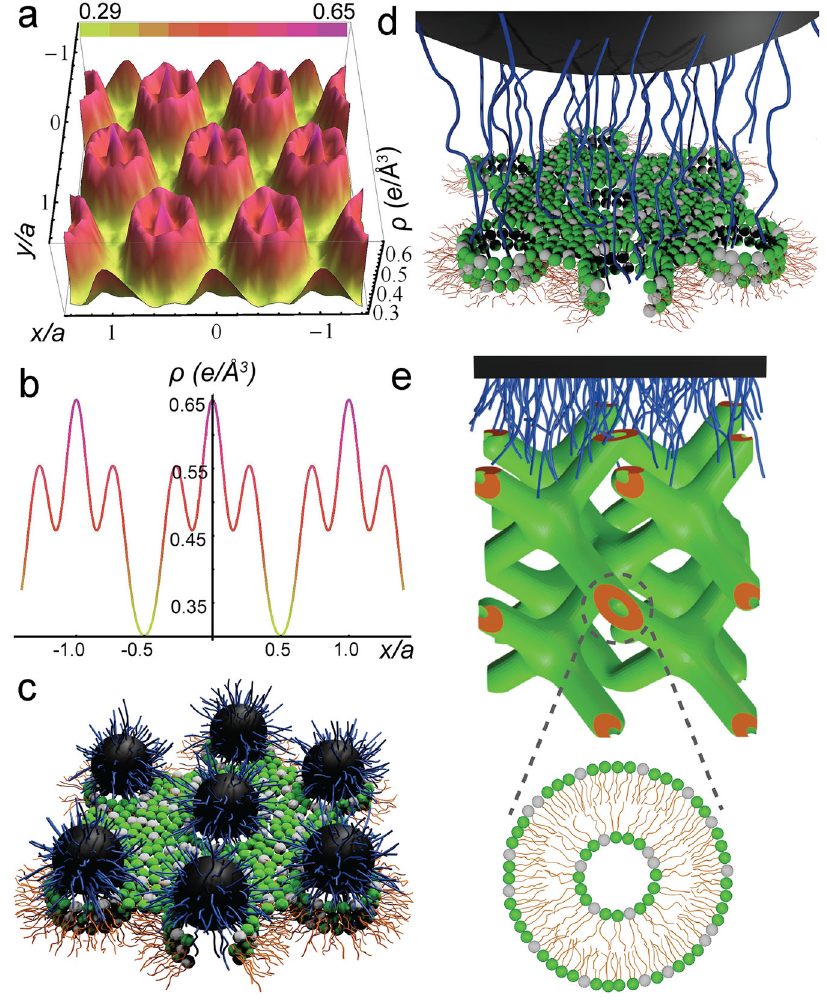
Fig. 5 The ability of hydrophilic NPPBs to induce pore formation on bacteria-mimicking membrane is critically dependent on the nanoparticle size. a Fourier reconstructed electron density map ( ρ ) of bacteria-mimicking membrane remodeled by S7 – P35 along the lattice plane de fi ned by x -axis and y -axis reveals that the remodeled membrane is in a honeycomb-like 2D inverted hexagonal phase ( H II ), the hallmark of membrane pore formation. The electron density map is color-coded, with a scale bar on the top indicating the variation from low (yellow) to high (magenta) electron density that ranges from 0.29 to 0.65 e/Å 3 . b Quantitative analysis of the electron density distribution along the unit cell axis (e.g., x -axis) helps elucidate the cooperative molecular rearrangement leading to H II formation: attractive interactions between polymer brushes and membrane surface induce a topological transition of the membrane to form pores, where the headgroups of lipids tilt inward to encircle strands of polymer brushes ( ρ = 0.65 e/Å 3 ) and constitute the edge of the pores ( ρ = 0.55 e/Å 3 ), with their hydrocarbon tails packed in-between the pores forming the wall ( ρ = 0.29 e/Å 3 ). c , d Schematic illustrations of the H II formation in the presence of two different NPPBs with increasing sizes, in which the bacteria-mimicking membrane is represented by a binary mixture of lipids (hydrocarbon tails in golden) with both PE (green) and PG (gray) headgroups, and NPPBs are shown by silica nanospheres (black) covalently grafted with polymer brushes (blue). e When the size of NPPBs increases beyond a threshold ( d silica ~ 50 nm), the 2D lipid H II phase gives way to a 3D lipid cubic phase (e.g., Pn3m ), a unit cell of which is schematically illustrated. Inset: a cross-sectional view of the lipid bilayer